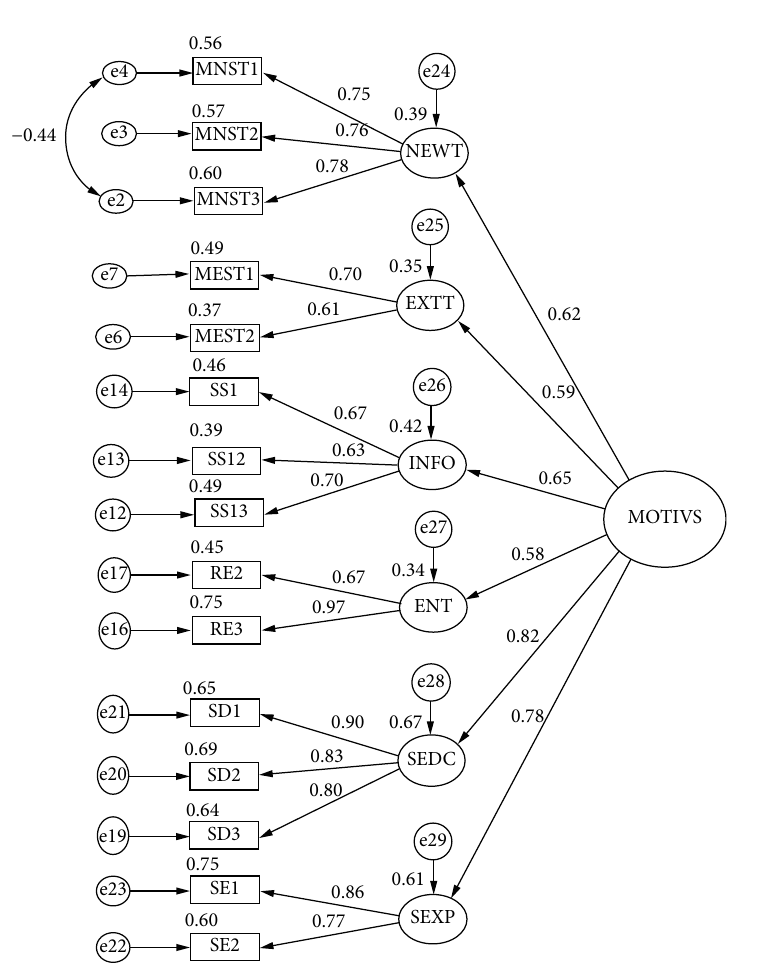
Figure 1: Structure of motivations to Facebook. MOTIVS: motivation, NEWT: new ties, EXTT: existing ties, INFO: information, ENT: entertainment, SEDC: self-documentation, SEXP: self-expression. Table 4 indicates that all the items were loaded on their relevant constructs. The values of standardized estimates range from 0.61 to 0.87. These values were signi fi cant and well above than the threshold value of 0.050.